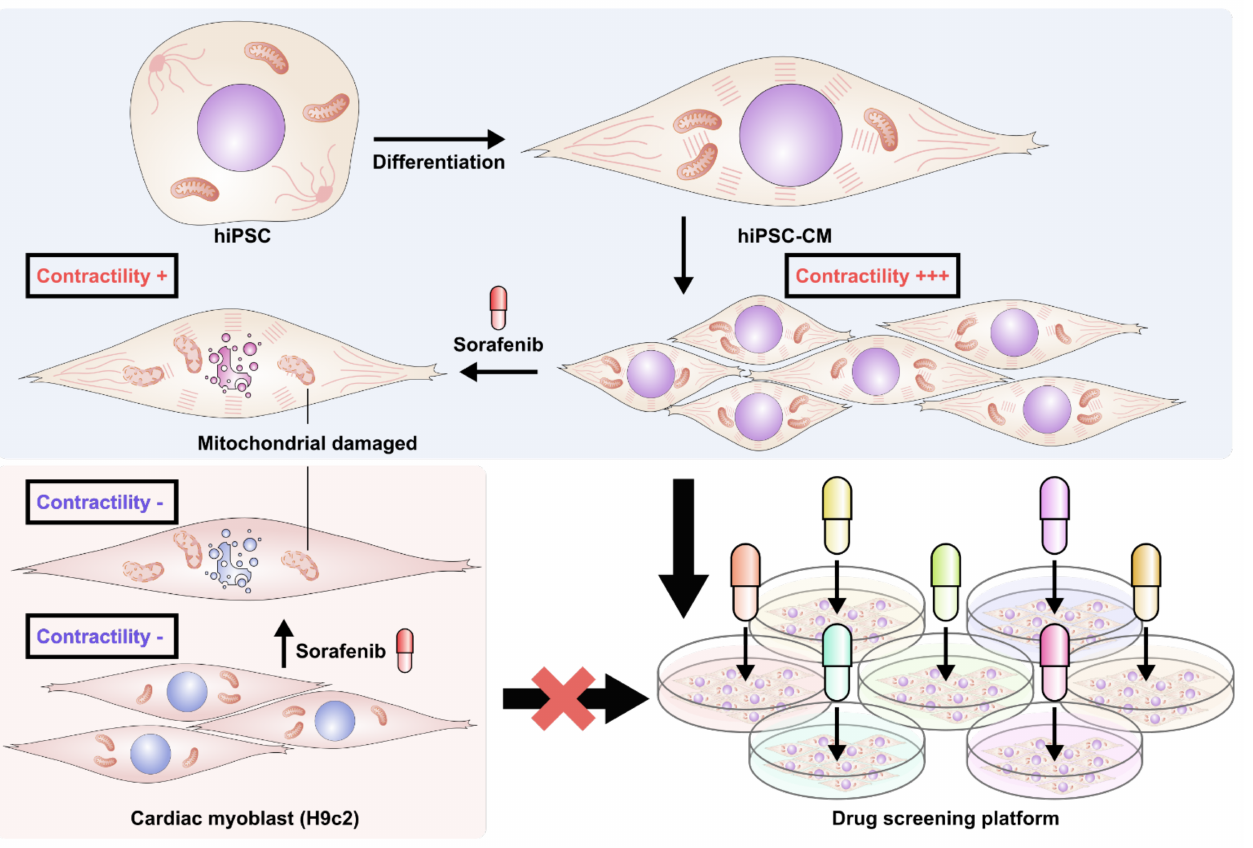
Figure 7. Diagrammatic illustration of preponderance of drug screening platform by iPSC-induced